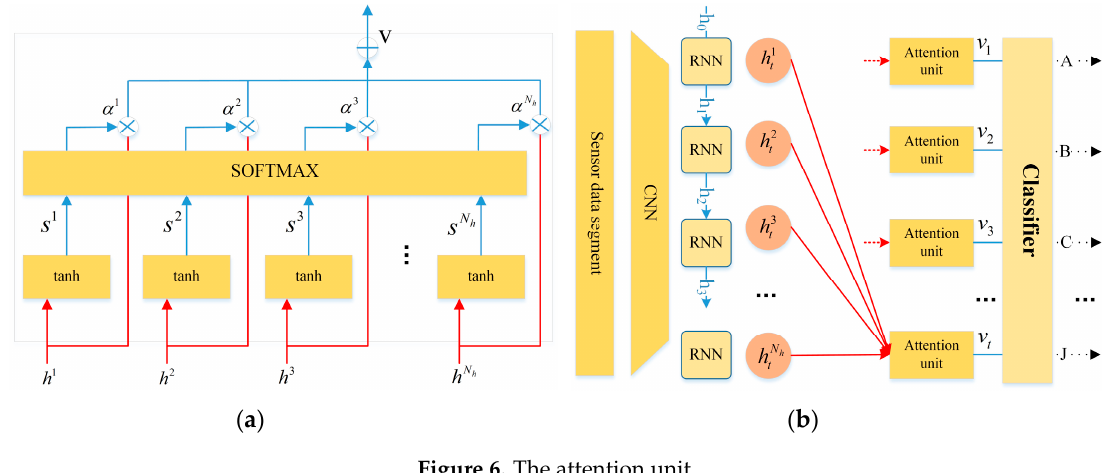
Figure 6. The attention unit.